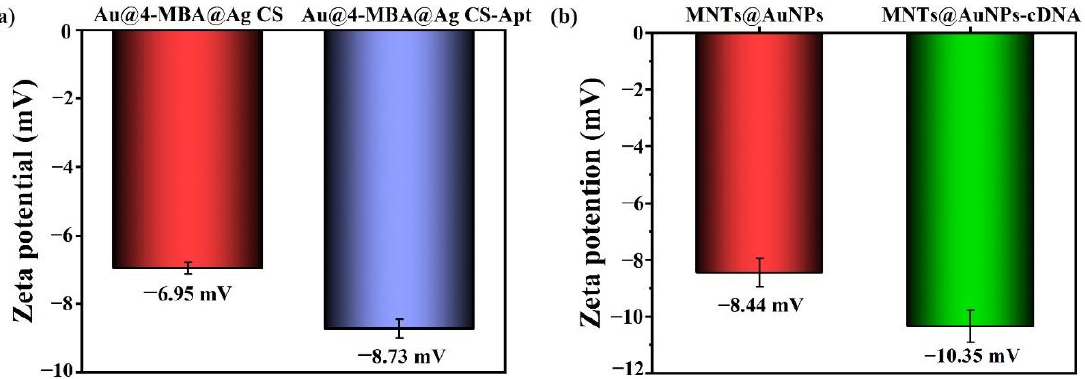
Figure 3. ( a ) Changes in the Zeta potential before and after modification of aptamer by Au@4- MBA@AgCS. ( b ) Changes in the Zeta potential before and after modification of BPA complementary chain by MNTs@AuNPs.